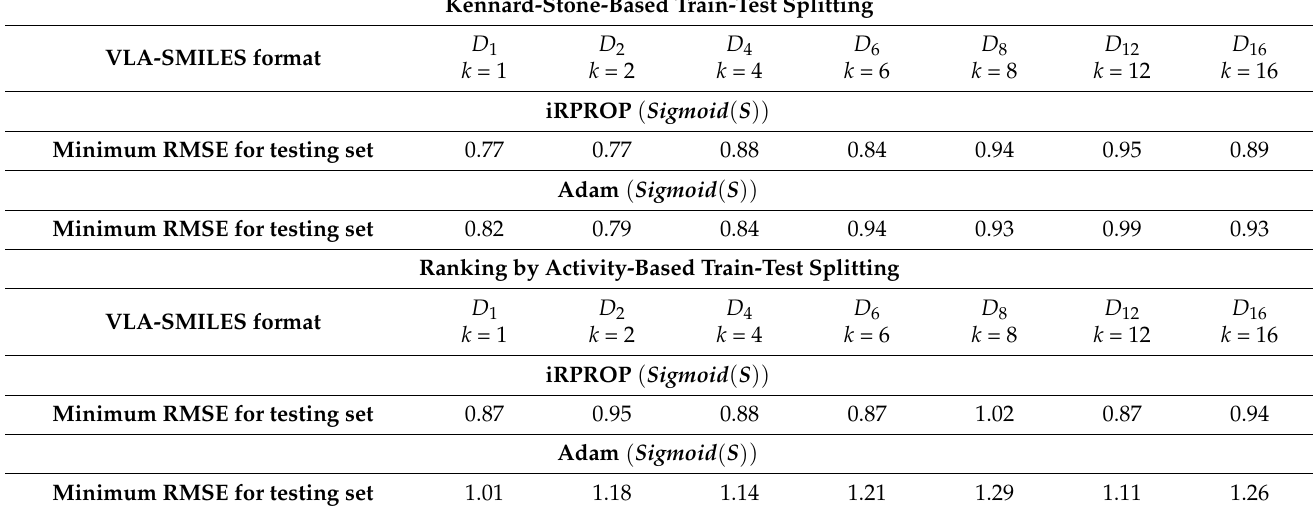
Table 1. RMSE values for testing sets of MLPs with one hidden layer and iRPROP − learning procedure: Kennard–Stone vs. ranking by activity-based train–test split ( Sigmoid activation function was used),